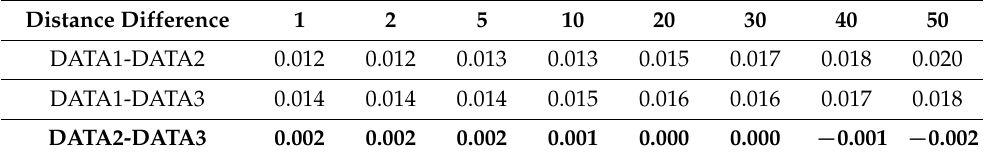
Table 20. The difference of correction for the three datasets at different distances (unit: